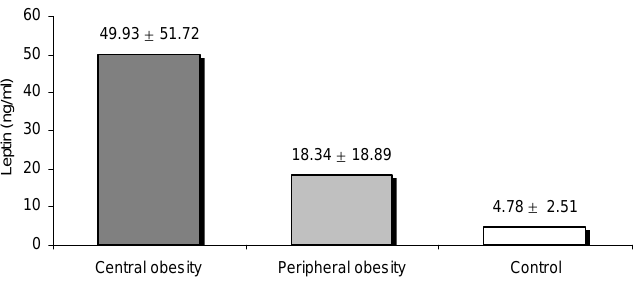
FIGURE 1. Leptin levels in different obesity types and control (mean ±